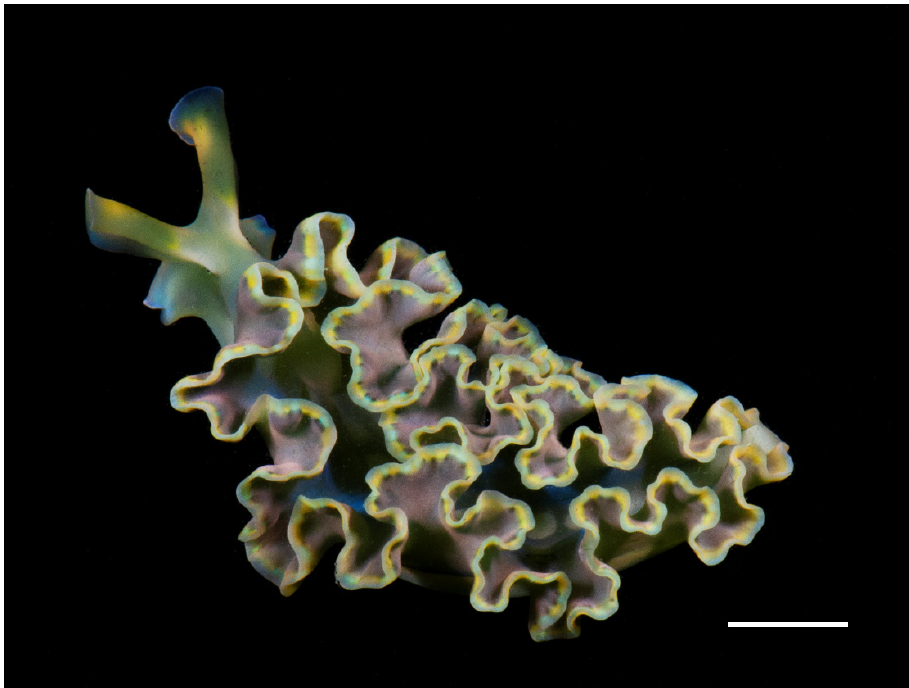
Figure 1. Specimen of Elysia crispata collected from the coral reef Verde (Sistema Arrecifal Veracruzano) in Veracruz, Southern Gulf of Mexico. Scale bar = 10 mm.